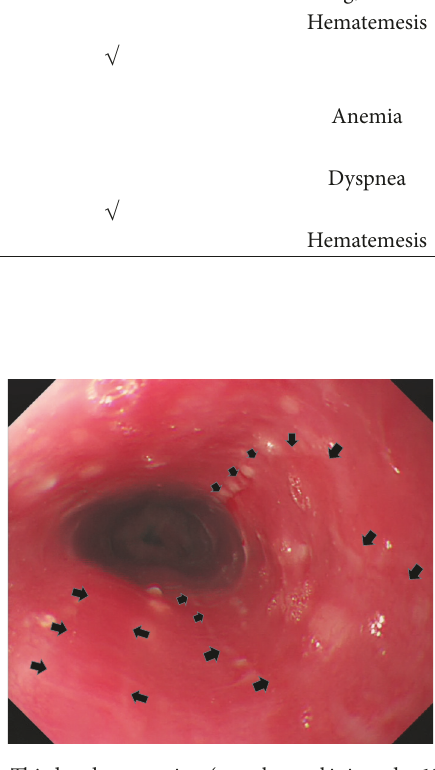
Figure3:Thirdendoscopyview(postthermalinjuryday10).Several healing hyperemic mucosa scar tracts along esophagus